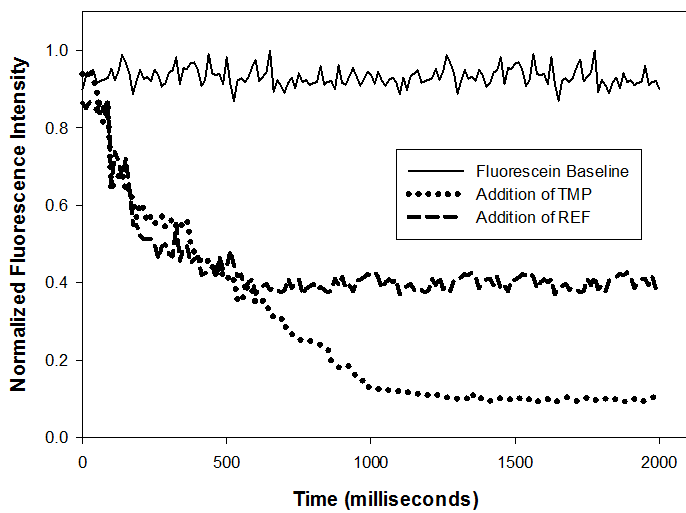
Figure 6 . Initial amount of 100 nM fluorescein in DI water was taken for a fluorescence baseline. Equal parts of fluorescein (100 nM) and TMP polymer solution (0.0355 g/L) were mixed together and normalized fluorescence intensity was measured over time (milliseconds). The same experiment was repeated with equal parts fluorescein (100 nM) and REF polymer solution (0.0355 g/L). While this experiment is too crude to permit an accurate rate constant measurement, it does show that binding is complete in 1.5 s, a considerable improvement on binding rates reported in the literature (2, 6, 10, 12). There are two reasons why our material responds more rapidly than other templated copolymers. One is the increased flexibility because our crosslinks are noncovalent and dynamic. The other is that high degrees of covalent crosslinking inevitably produce a bulk phase rather than a copolymer that is soluble in water. In these materials, the rate of response depends on how rapidly the template diffuses through the bulk phase. 4. Conclusions The data presented here show that a templated copolymer with predominantly noncovalent crosslinks binds rapidly and selectively with larger affinity constants than structurally rigid conventional templated copolymers with much higher levels of covalent crosslinking. Further work needs to be done to characterize this type of templated copolymer, to establish the nature of the crosslinking and to further evaluate selectivity. Nevertheless, the approach presented here, which mimics nature, suggests a useful new strategy for preparing high affinity templated copolymers with rapid binding kinetics. Author Contributions: Casey J. Grenier performed most of the experiments presented in the manuscript and wrote the first draft of this manuscript. Anthony Timberman measured and interpreted the NMR spectra of TMP and REF. Rongfang Yang increased our knowledge in this area by preparing other templated copolymer using RAFT. John Csoros introduced RAFT to the Seitz research group and has served as our expert on this polymerization method. Alex Papantones performed important preliminary experiments with templated, uncrosslinked copolymers. Leila F. Deravi met with the investigators on a weekly basis and provided valuable consulting on all aspects of this projects. W. Rudolf Seitz came up with this ideas that go into this research and wrote the final draft of this paper.